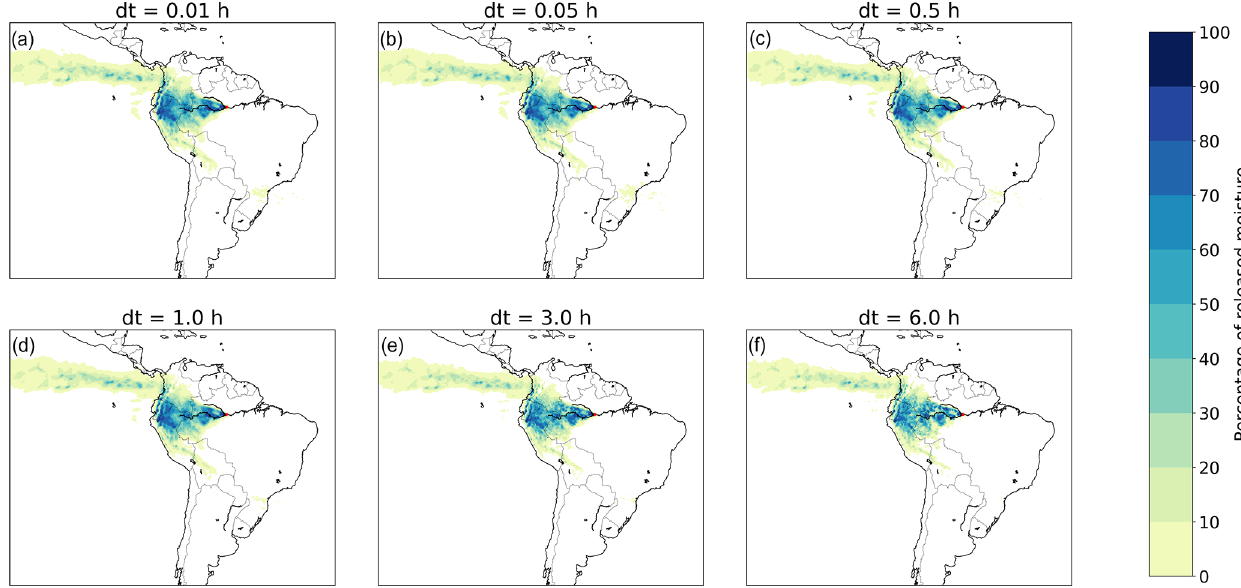
Figure 9. Different footprints of moisture releases from Manaus in July 2012 in a three-dimensional Lagrangian model with different time steps (dt): 0.01, 0.05, 0.5, 1.0, 3.0, and 6.0h. (a) 0.01h, with a mean latitudinal moisture flow of 1.4 ◦ in a northerly direction and mean longitudinal flow of 14.3 ◦ in a westerly direction; (b) 0.05h, with a mean latitudinal moisture flow of 1.3 ◦ in a northerly direction and mean longitudinal flow of 14.2 ◦ in a westerly direction; (c) 0.5h, with a mean latitudinal moisture flow of 1.5 ◦ in a northerly direction and mean longitudinal flow of 14.4 ◦ in a westerly direction; (d) 1.0h, with a mean latitudinal moisture flow of 1.5 ◦ in a northerly direction and mean longitudinal flow of 14.5 ◦ in a westerly direction; (e) 3.0h, with a mean latitudinal moisture flow of 1.6 ◦ in a northerly direction and mean longitudinal flow of 14.3 ◦ in a westerly direction; (f) 6.0h, with a mean latitudinal moisture flow of 1.7 ◦ in a northerly direction and mean longitudinal flow of 14.2 ◦ in a westerly